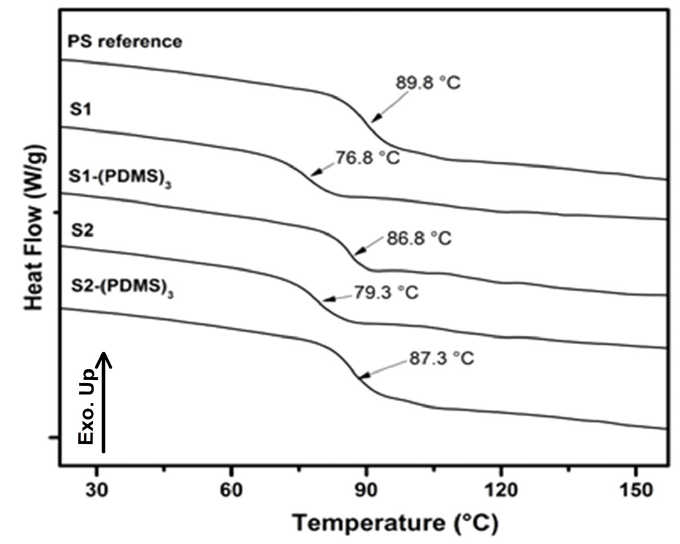
Fig 7. DSC thermograms for a PS reference, precursors and the corresponding samples end-capped with 3-short-arm PDMS.